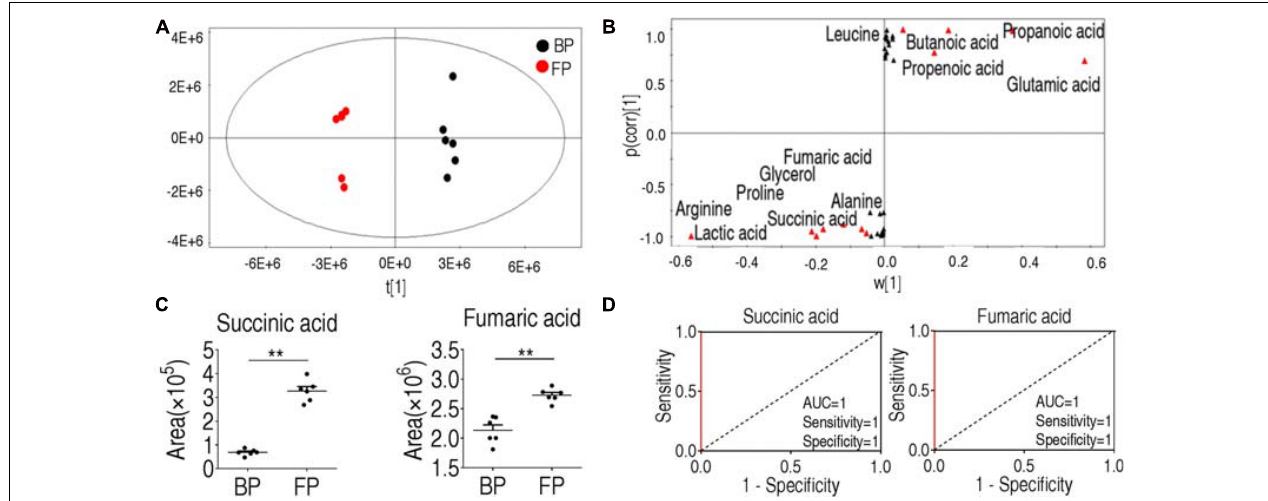
FIGURE 4 | Identification of crucial biomarkers before and after phagocytosis. (A) OPLS-DA analysis of metabolic data before and following phagocytosis. Each point represents a technical replicate of the sample. (B) S-plot. p [1] and correlation p(corr) [1] distinguish monocytes/macrophages before and after phagocytosis. (C) Succinate and fumarate were the crucial biomarkers for phagocytosis. (D) ROC curve of biomarkers for phagocytosis. * p < 0.05; ** p <